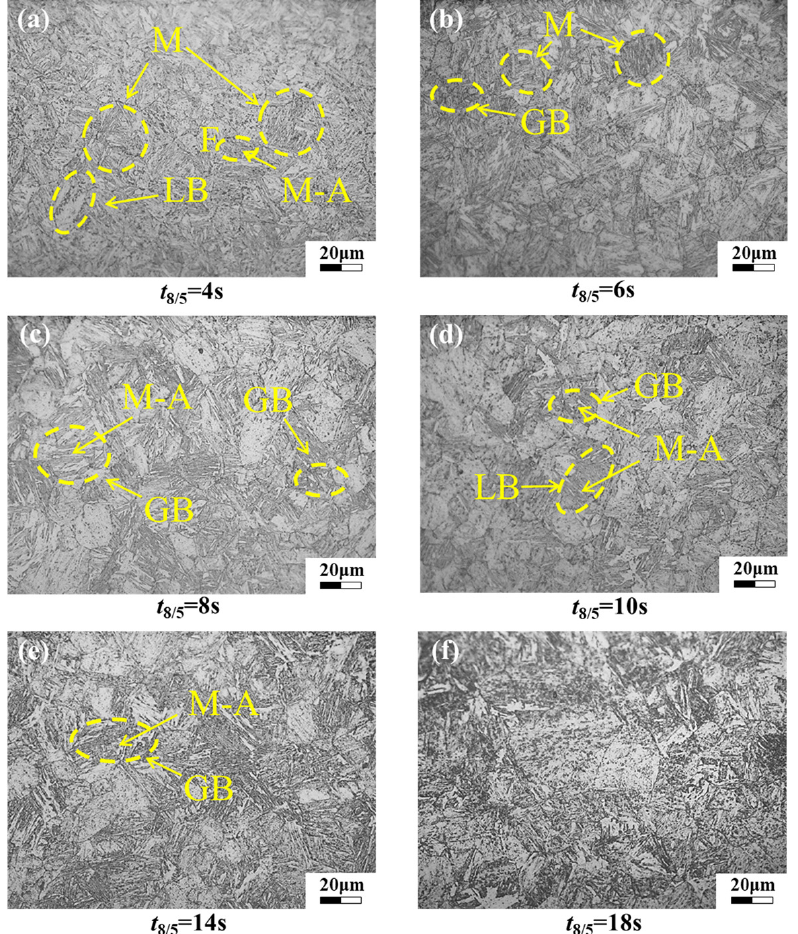
Figure 5. Different t 8/5 thermal simulations of the HAZ microstructure (OM) when T max = 1250 °C. ( a ) t 8/5 = 4 s; ( b ) t 8/5 = 6 s; ( c ) t 8/5 = 8 s; ( d ) t 8/5 = 10 s; ( e ) t 8/5 = 14 s; ( f ) t 8/5 = 18 s.